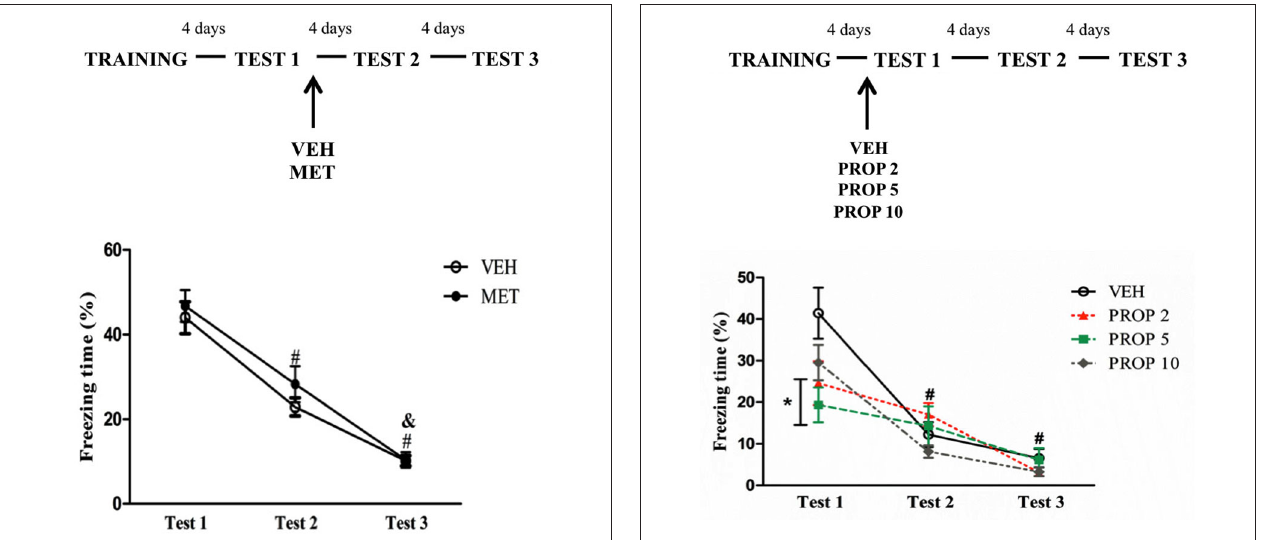
FIGURE 2 | Post-reactivation acute metyrapone treatment did not modify fear memory expression . Metyrapone treatment immediately